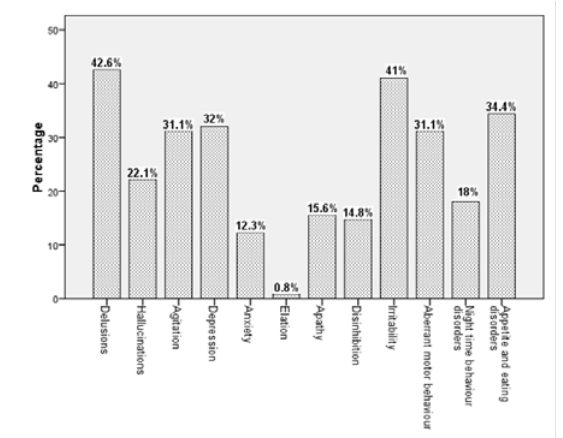
Figure 1. Proportions of varying behavioural and psychological symptoms of dementia among participants in this